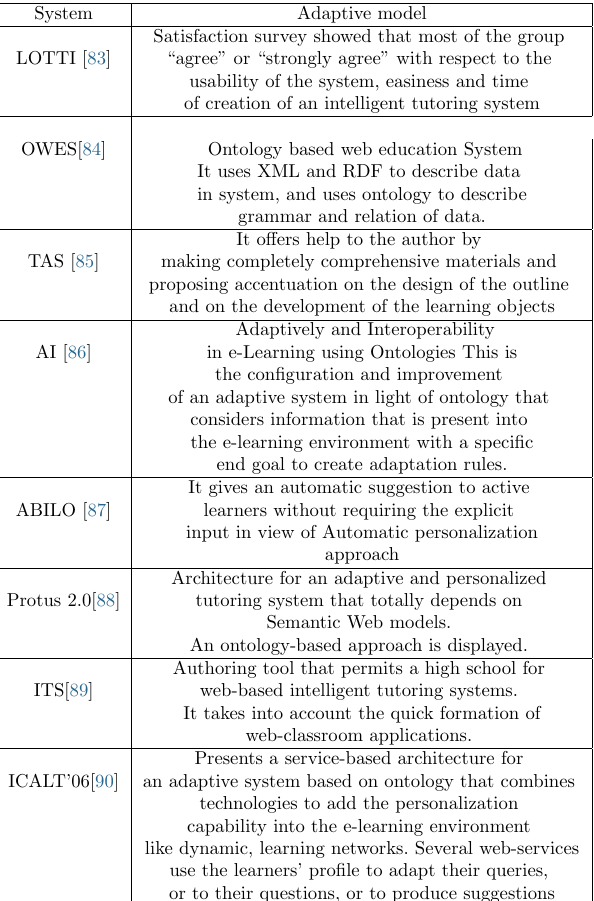
Table 4. Adaptive e-learning